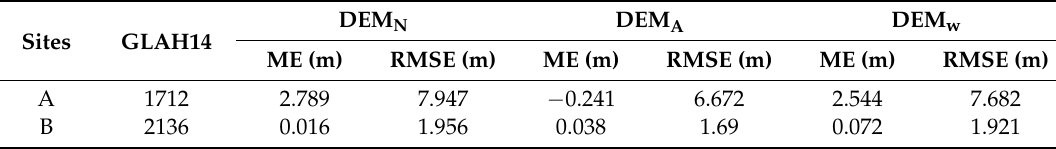
Figure 12. Plots of the DEM N against the GLAH14 in different slope position classes at ( a – f ) site A, and ( g – i ) site B. Table 5. Performance of the adjusted DEM in comparison with the DEM N at study sites A and